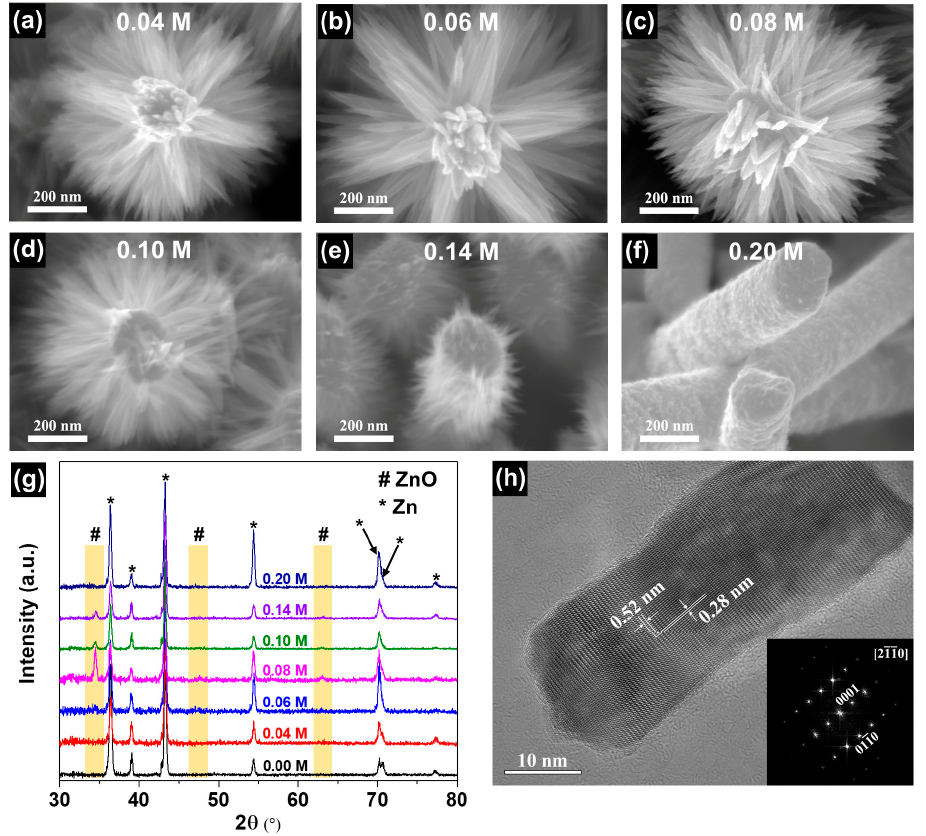
Figure 2. SEM images of B-ZnO NWA prepared in ( a ) 0.04 M, ( b ) 0.06 M, ( c ) 0.08 M, ( d ) 0.10 M, ( e ) 0.14 M, and ( f ) 0.20 M NaOH solution. ( g ) XRD patterns of B-ZnO NWA prepared in NaOH solution with different concentrations. ( h ) HRTEM image of a ZnO branch, the inset is the corresponding FFT pattern.